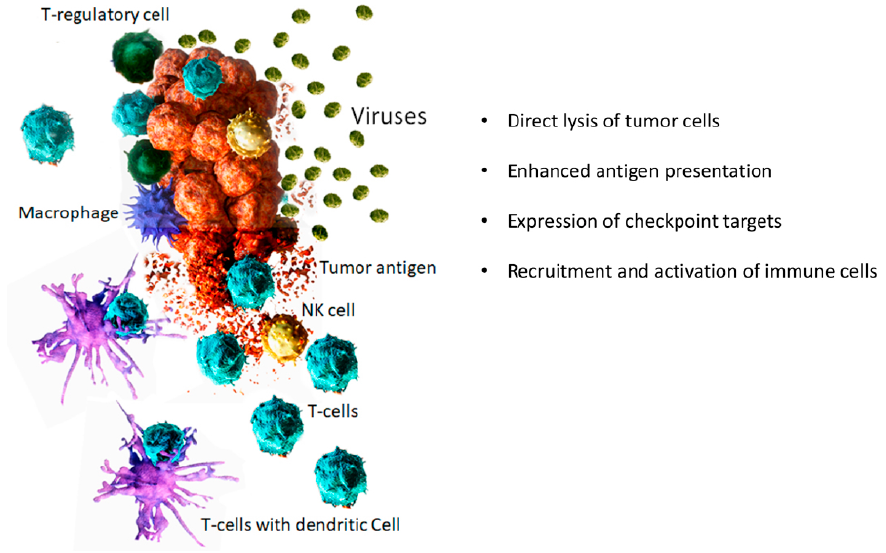
Figure 1. Mechanisms of tumor destruction by oncolytic